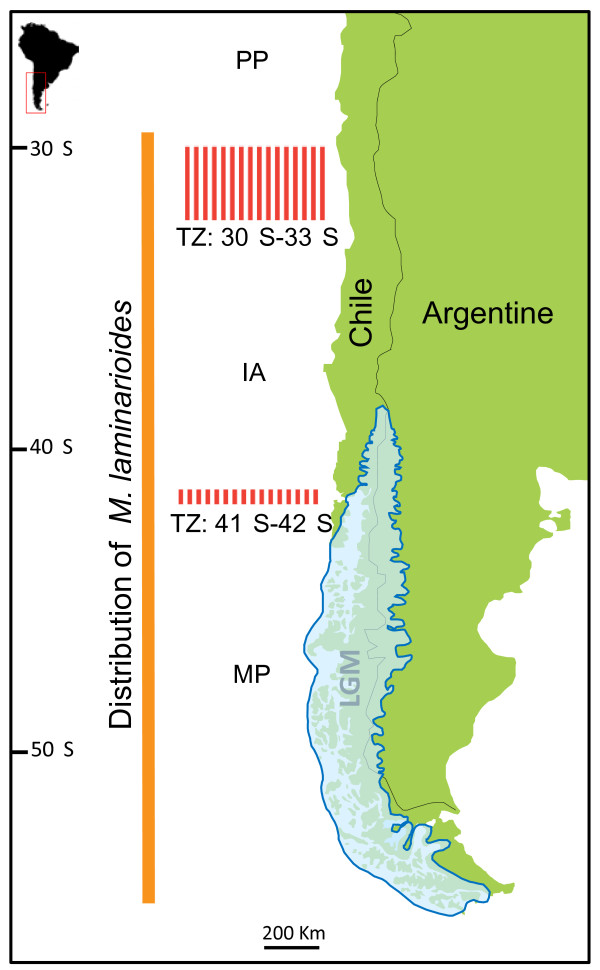
Geographical context of the phylogeographic study on the red seaweed Mazzaella laminarioides . Map of the Chilean coast showing the extension of the two biogeographic transition zones (TZ, red bars) [27]; the extent of ice during the Last Glacial Maximum (LGM; blue area) modified from [28], and the geographical distribution of M. laminarioides (orange line). Abbreviations indicate the three biogeographic provinces described for the Chilean coast: (PP) Peruvian Province, (IA) Intermediate Area, and (MP) Magellanic Province.